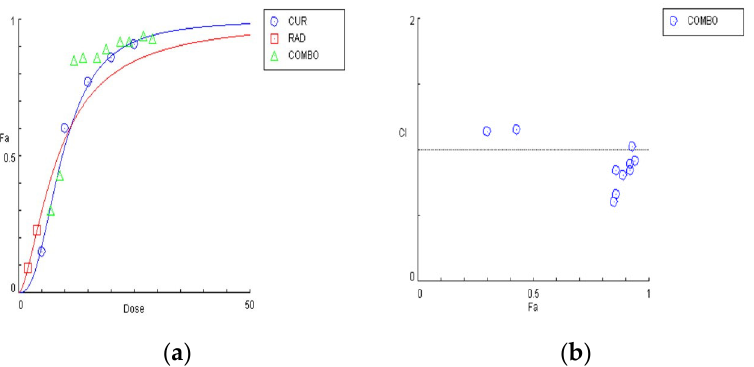
Figure 4. Graphical presentations obtained from the CompuSyn Report for the curcumin and radiation combination in U87 cells. ( a ) Dose–effect curve; ( b ) combination index plot.